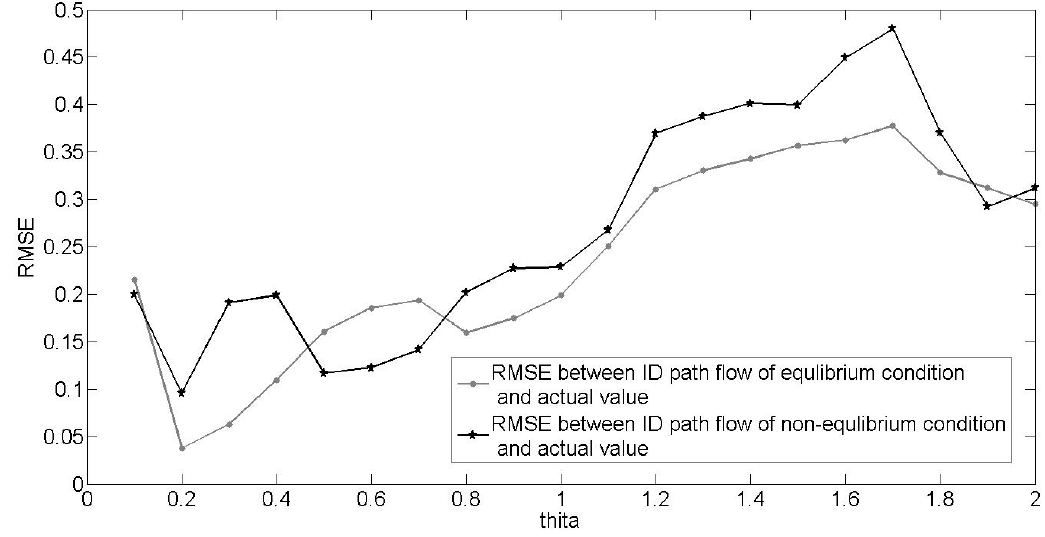
Figure 7. A comparison of equilibrium and nonequilibrium assignments.